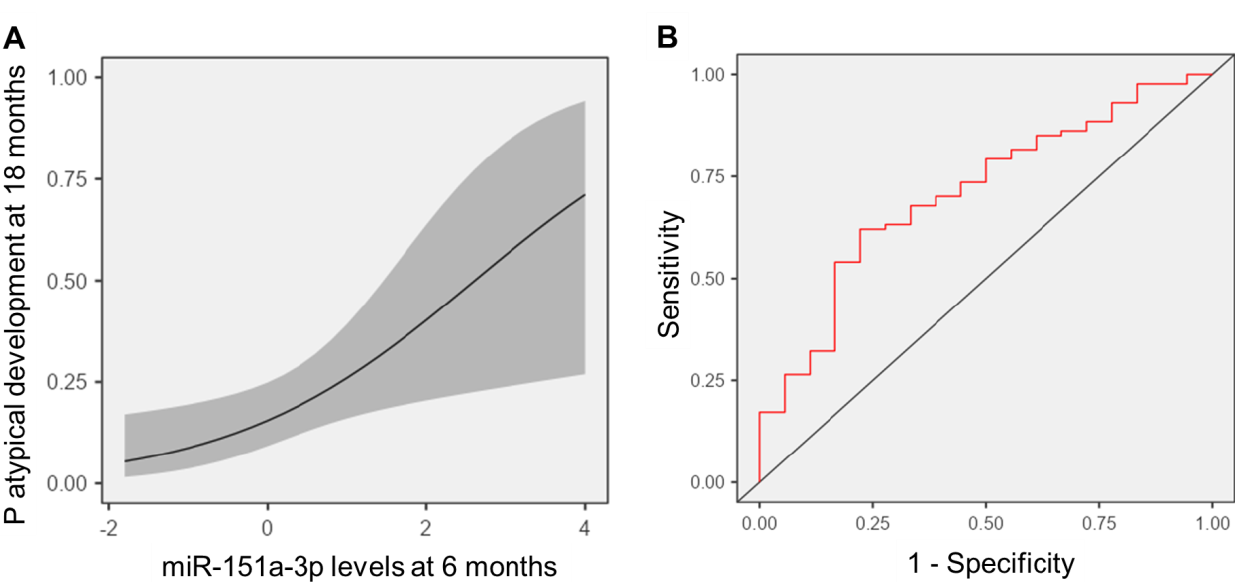
Figure 3. Salivary levels of miR-151a-3p at 6 months aid prediction of neurodevelopmental delay at